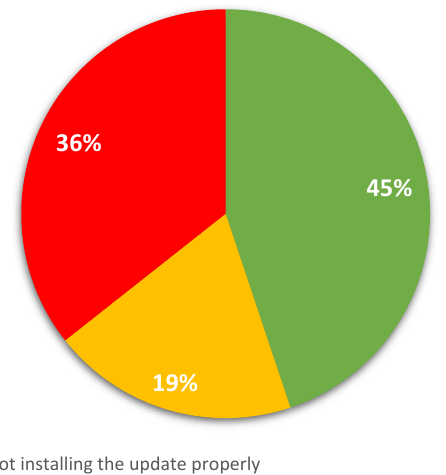
Figure 5. Liability in the case of not installing an available software update. Source: Author’s pro-